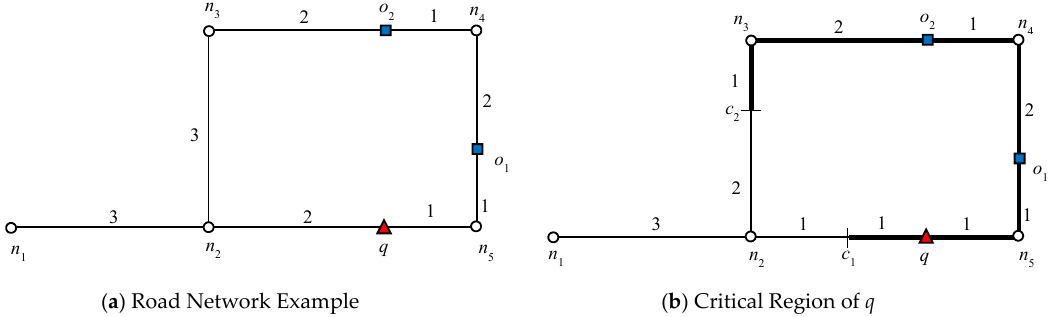
Figure 12. Difference between original safe region SR or and compressed safe region SR co . ( a ) Road Network Example; ( b ) Critical Region of q.